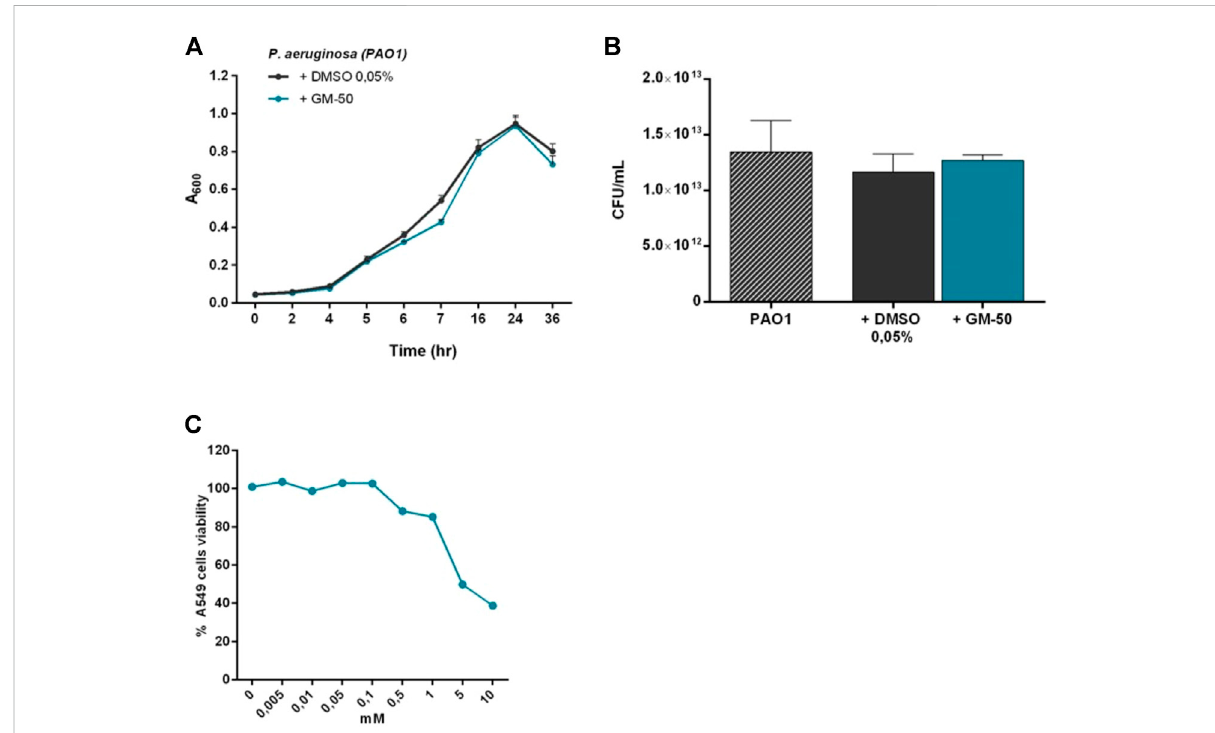
FIGURE 2 Effect of GM-50 on prokaryotic and eukaryotic cells growth and viability. PAO1 (10 6 CFU/ml) cultures were treated with 100 µM of GM-50 or vehicle. (A) Bacterial growth was monitored for 36 h by measuring optical density (OD = 620 nm). (B) Bacterial viability was evaluated by seeding proper culture dilutions in LB agar and enumerating colonies (CFU) after 16 h ( n = 3) (C) Human respiratory tract epithelial cells A549 were cultured with GM-50 at concentrations ranging from 0 to 10 mM. Cell viability was assessed by MTT (3- (4,5-dimethylthiazol-2-yL)-2,5- diphenyltetrazolium bromide) assay. Data ( n = 3) are reported as percent cell viability calculated over the control